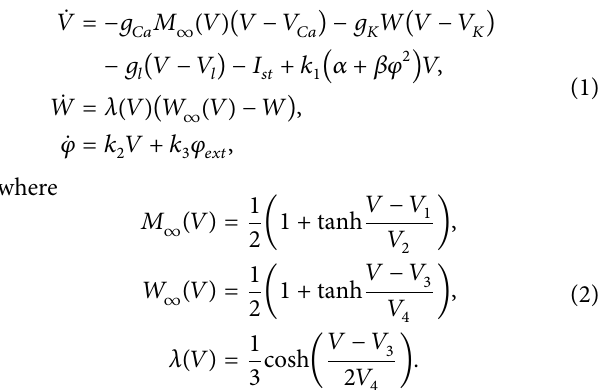
, 𝑘 , and 𝑘 1 = 0.2 2 = 0.15 3 = 0.15